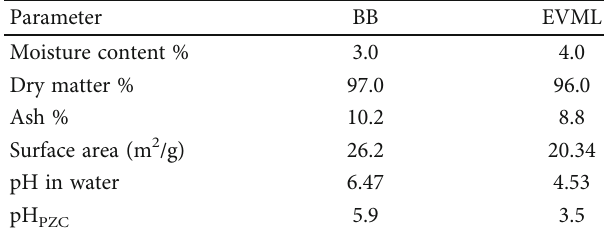
Table 1: Physiochemical properties of BB and EVML